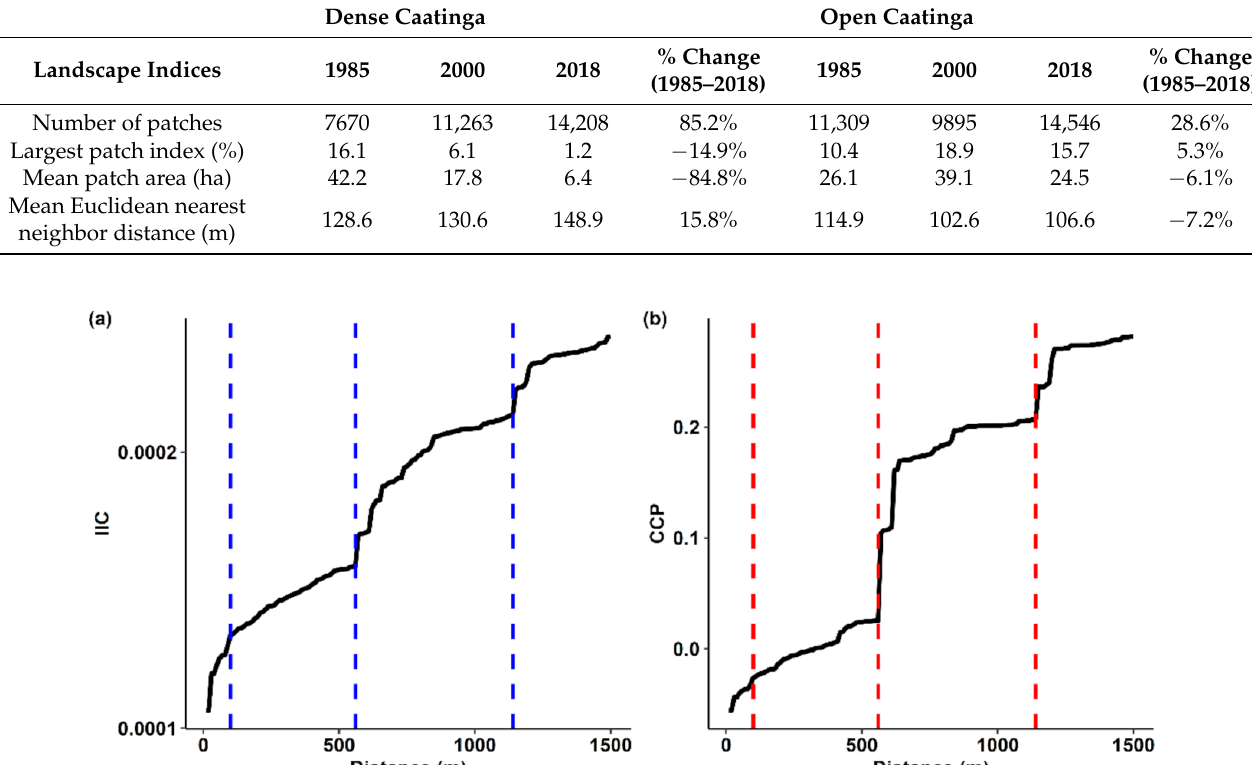
Figure 5. IIC ( a ) and CCP ( b ) values for connectivity distances from 10 to 1500 m. Based on these data, the connectivity distances used for the subsequent analysis were set at 100, 560 and 1140 m for dense Caatinga (shown in dashed lines).